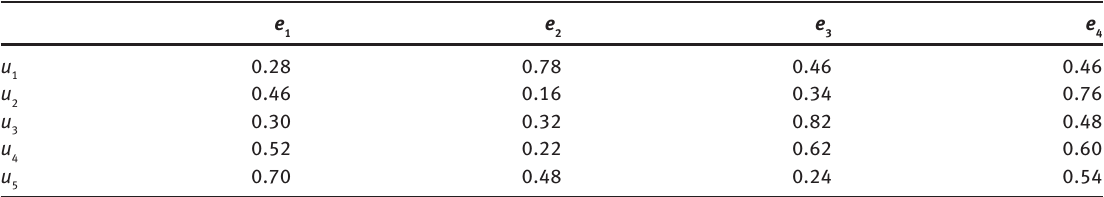
Table 4: Weighted average of opinions.